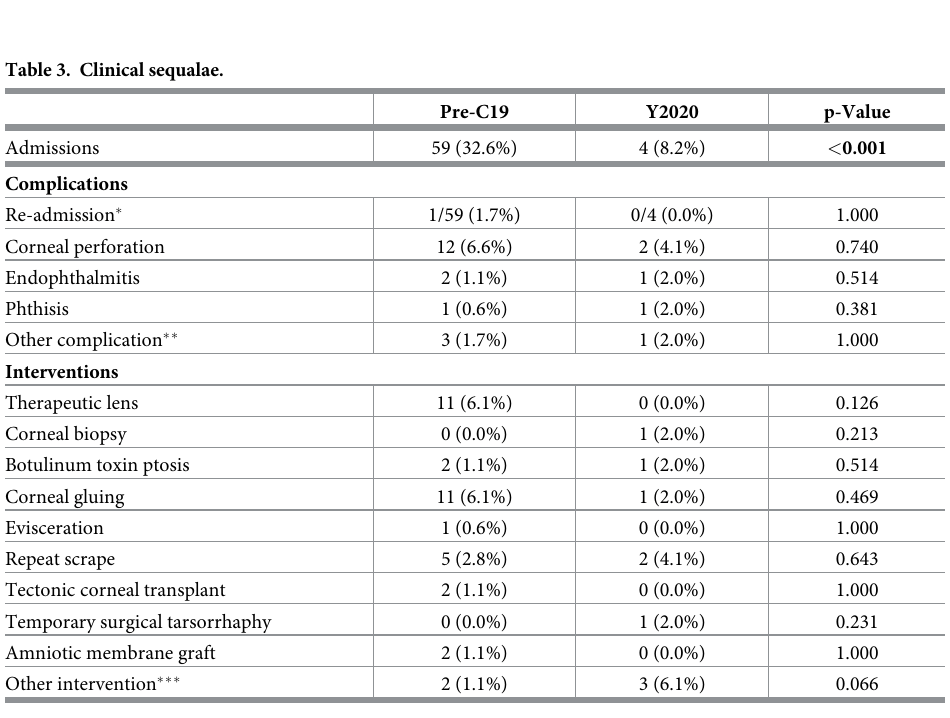
Table 3. Clinical